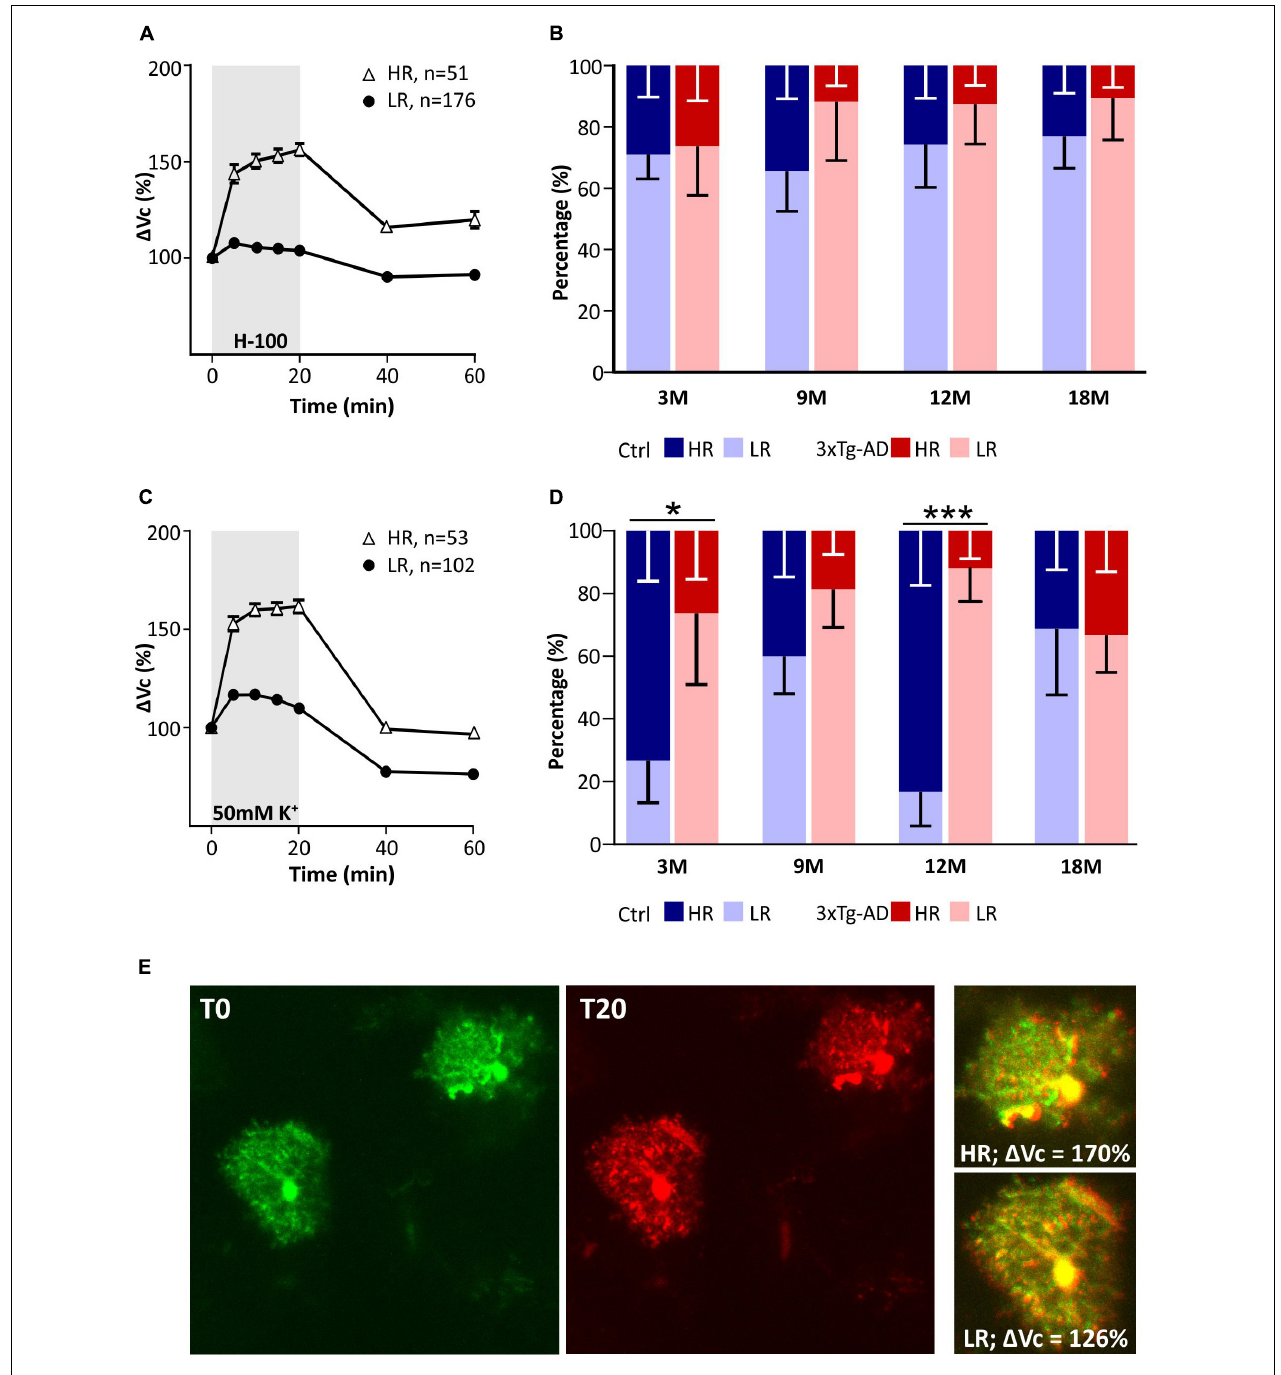
FIGURE 8 | Characterization of two groups of EGFP-positive astrocytes responding to pathological conditions with high or low rate of swelling identified in hippocampus of controls and 3xTg-AD mice. Subpopulations differ in the size of the swelling and the course of volume changes during the exposure to hypo-osmotic stress (A) or hyperkalemia (C). Comparison of the incidence of HR- and LR-astrocytes between controls and 3xTg-AD in individual age groups in hypo-osmotic stress (B) or hyperkalemia (D) . Note that the number of astrocytes responding with a low rate of swelling is significantly increased in 3- and 12M-old 3xTg-AD mice. (E) Representative images of HR- and LR- EGFP-expressing astrocytes before (T0, red) and after the 20-min exposure to 50 mM K + (T20, green). Overlays show merged images of cells with their initial volume (red) and swollen cells (green). Green area represents swelling induced by 50 mM K + . Data are presented as mean ± SEM. Statistical significance was determined by two-way ANOVA test with Tukey’s post hoc test. Asterisks indicate significant differences (* p < 0.05, *** p < 0.001). Ctrl, control; 3xTg-AD, triple transgenic model of AD crossbred with GFAP/EGFP mice; HR, high-responding astrocytes; LR, low-responding astrocytes; H-100, hypotonic artificial cerebrospinal; 50 mM K+, artificial cerebrospinal fluid with elevated K + concentration; 3M, 9M, 12M, 18M, 3-, 9-, 12-, 18-month-old animals; n, number of cells.